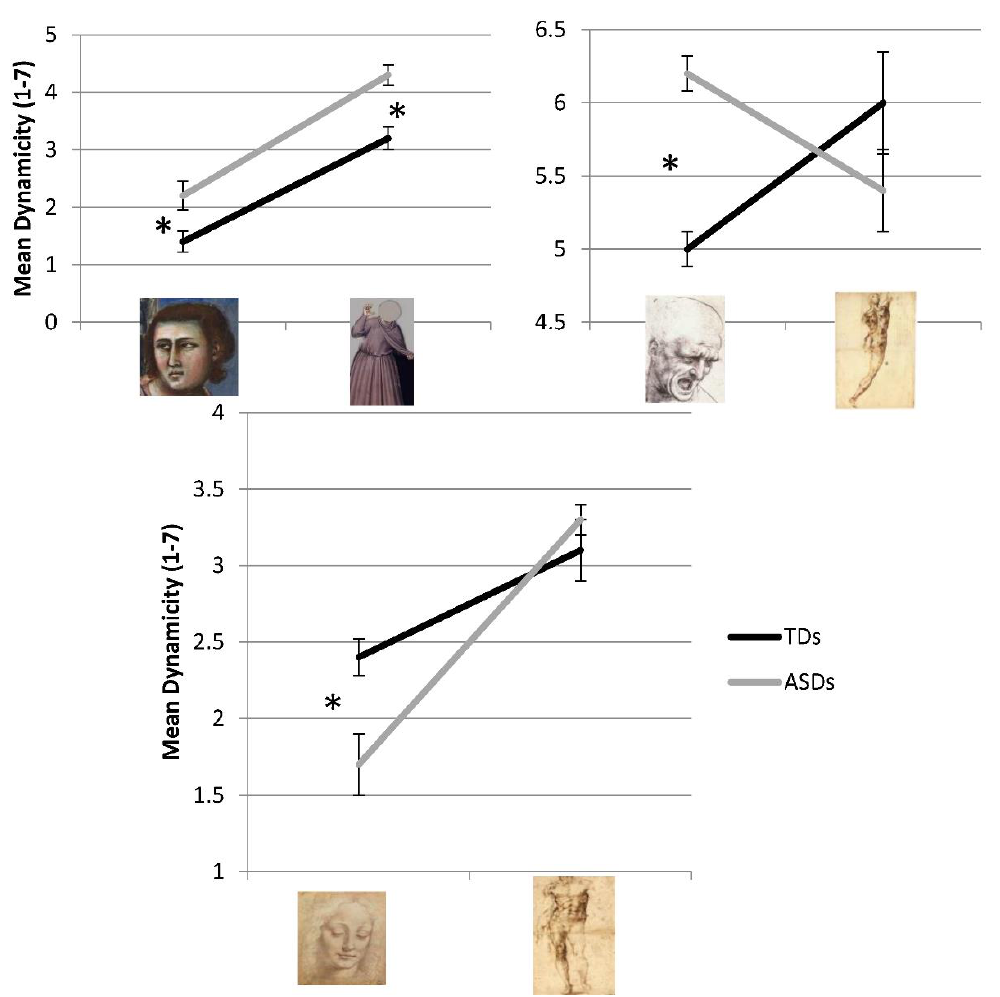
Figure 10. Level of dynamicity perceived by the two groups in bodiless heads (left) and headless bodies (right) for images 12a,b (upper left panel), 13a,b (upper right panel) and 14a,b (lower panel), respectively. Asterisks highlight significantly different means.